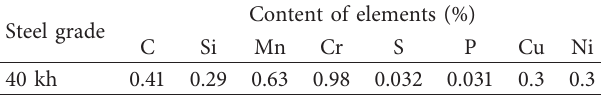
Table 1: Chemical composition of 40 kh steel. Steel